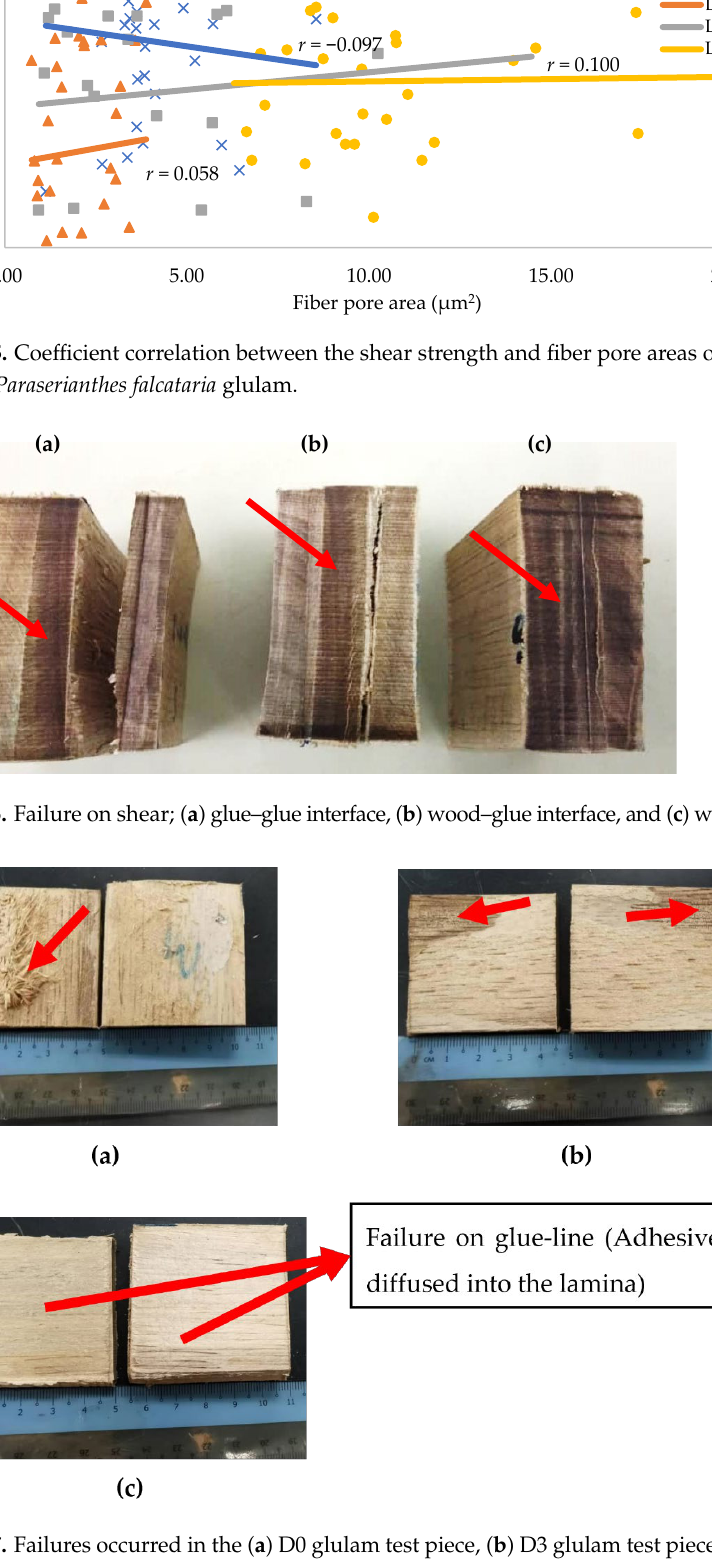
Figure 7. Failures occurred in the ( a ) D0 glulam test piece, ( b ) D3 glulam test piece, and ( c ) D9 glulam test pieces.